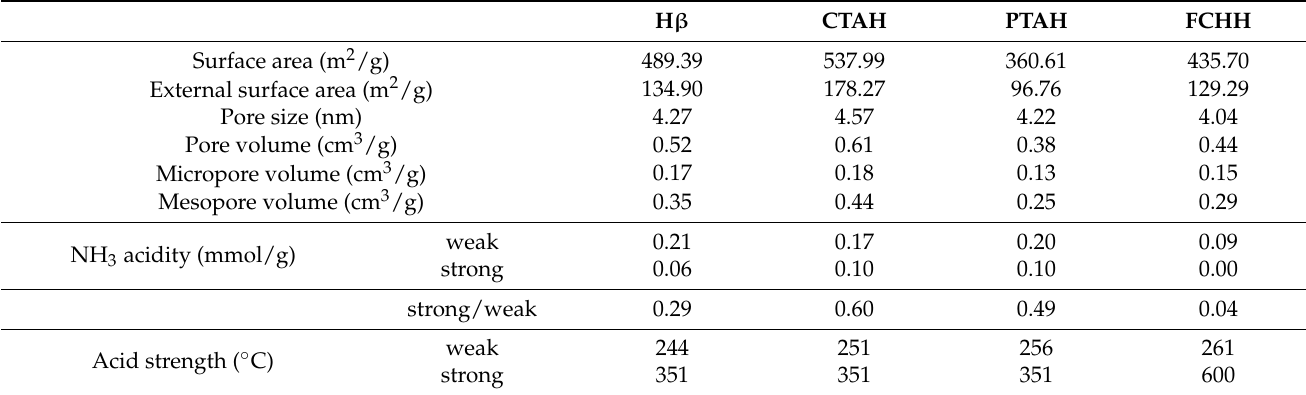
Table 2. Surface and acidic properties of various solid acid